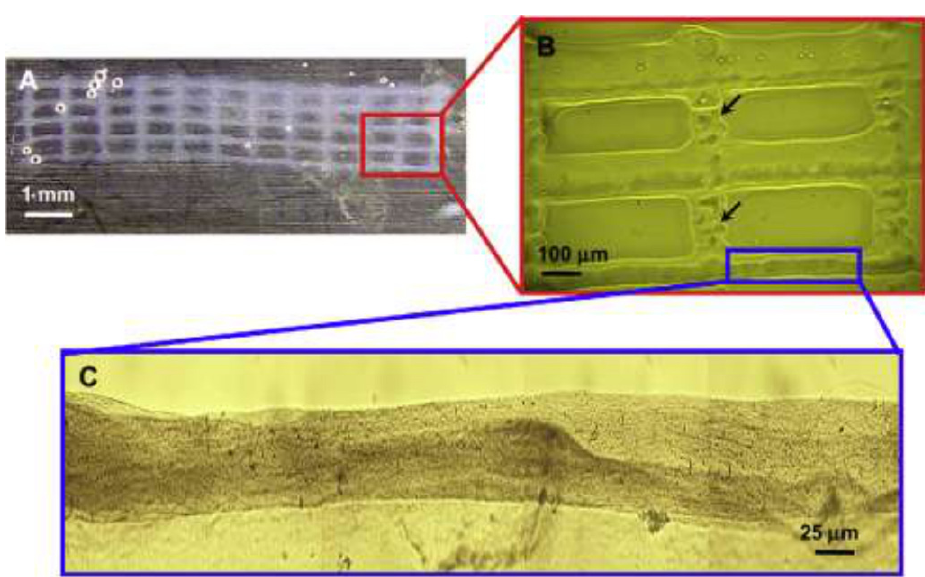
Figure 5. Images of printed fibrin scaffold seen under light microscope